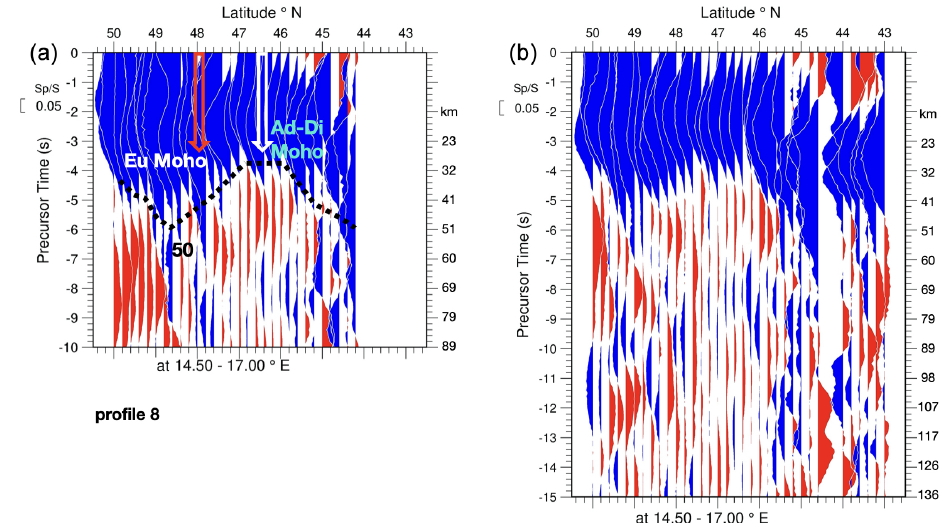
Figure 10. Profile 8. North–south profiles at 14.5–17 ◦ E. As in profile 7 in Fig. 9, the Moho culminates near the junction of European and Adriatic Moho at latitude 46.5 ◦ (i.e. at the Mid-Hungarian Fault Zone marked with a white arrow). Ad-Di denotes the Moho beneath the undeformed Adria plate dipping to the NE beneath the Dinarides. The red arrow indicates the location of the frontal thrust of the Alpine